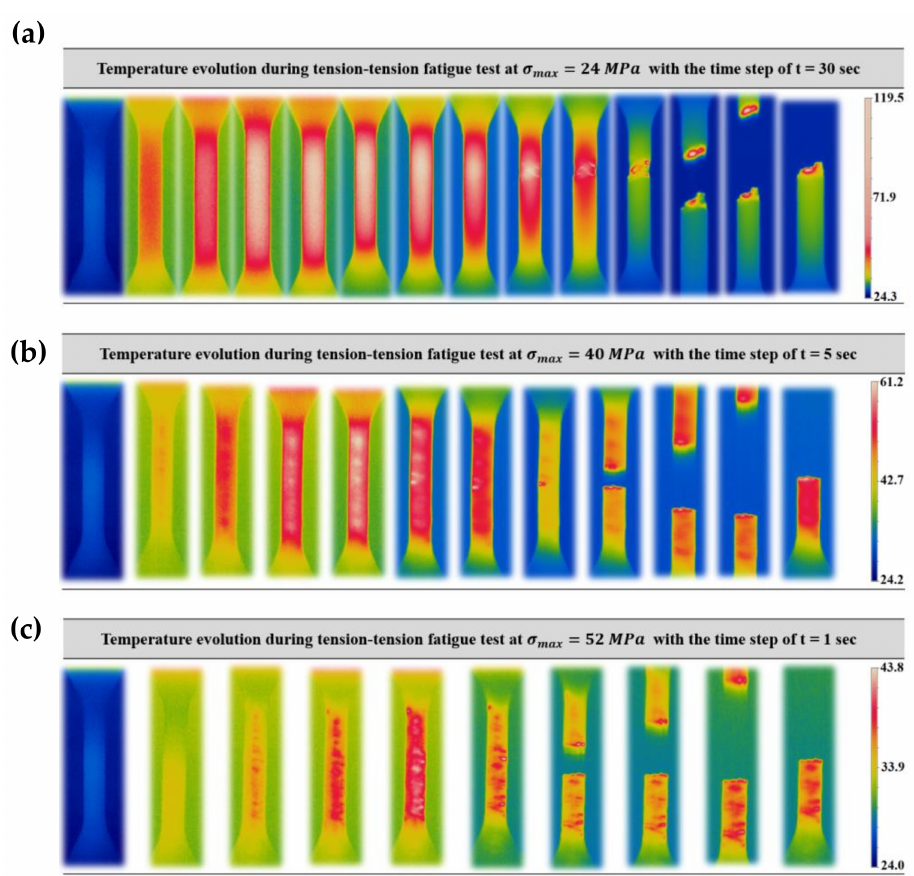
Figure 10. Induced temperature under tension–tension fatigue test for condition III-3 at frequency of 80 Hz: ( a ) low amplitude, ( b ) medium amplitude, and ( c ) high